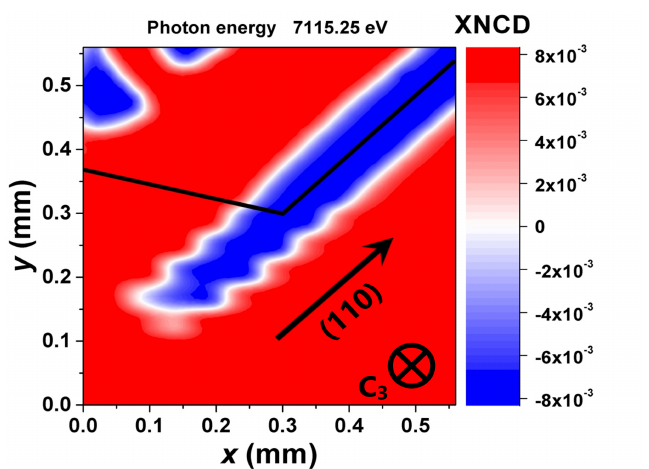
Figure 6. XNCD images recorded at room temperature for the racemic SmFe 3 (BO 3 ) 4 single crys- tal along the trigonal c -axis at the Fe K -edge energy fixed at the maximum of the XNCD signal (7115.25 keV) as a function of coordinates. It shows clear evidence that the crystal comprises orienta- tionally distinct domains. The black line shows the angle of 120 ◦ inherent three-fold rotation in the R 32 space group. The direction of the third-order axis and the (110) crystal plane are shown (checked by Laue diffraction, Photonic Science). Image size: 560 × 560 µ m 2